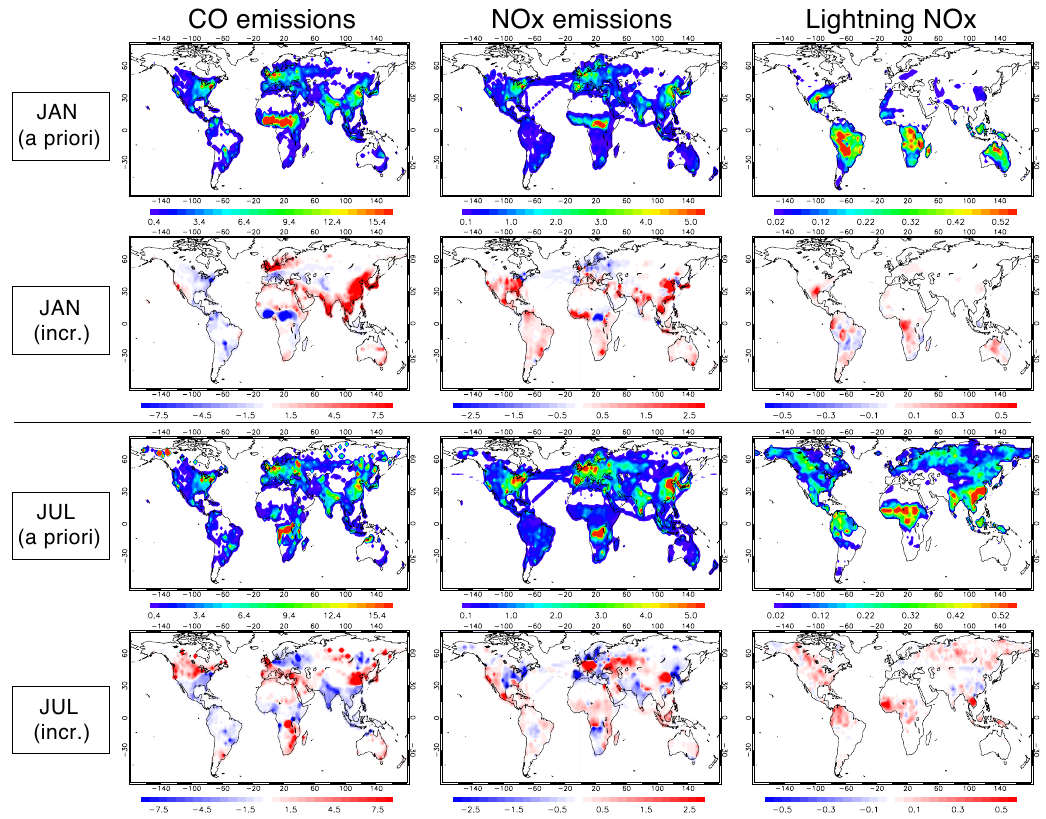
Fig. 14. Global distributions of the surface CO emissions (in 10 − 10 kgm − 2 s − 1 ) (left panels), the surface NO x emissions (in 10 − 11 kgm − 2 s − 1 ) (centre panels), and the lightning NO x emissions (in 10 − 11 kgm − 2 s − 1 ) (right panels), averaged over the 16–30 Jan- uary (upper 6 panels) and July (lower 6 panels) in 2007. The a priori emissions (upper rows) and the analysis increment (lower rows), i.e. the difference between the a posteriori and the a priori, are shown for each panel. The red (blue) colour indicates an emission increase (decrease) for the analysis increment, respectively. Table 8. Same as in Table 7, but for the regional surface CO emissions ( e( CO), in TgCOyr − 1 ). January July A posteriori newer inventories A priori A posteriori newer